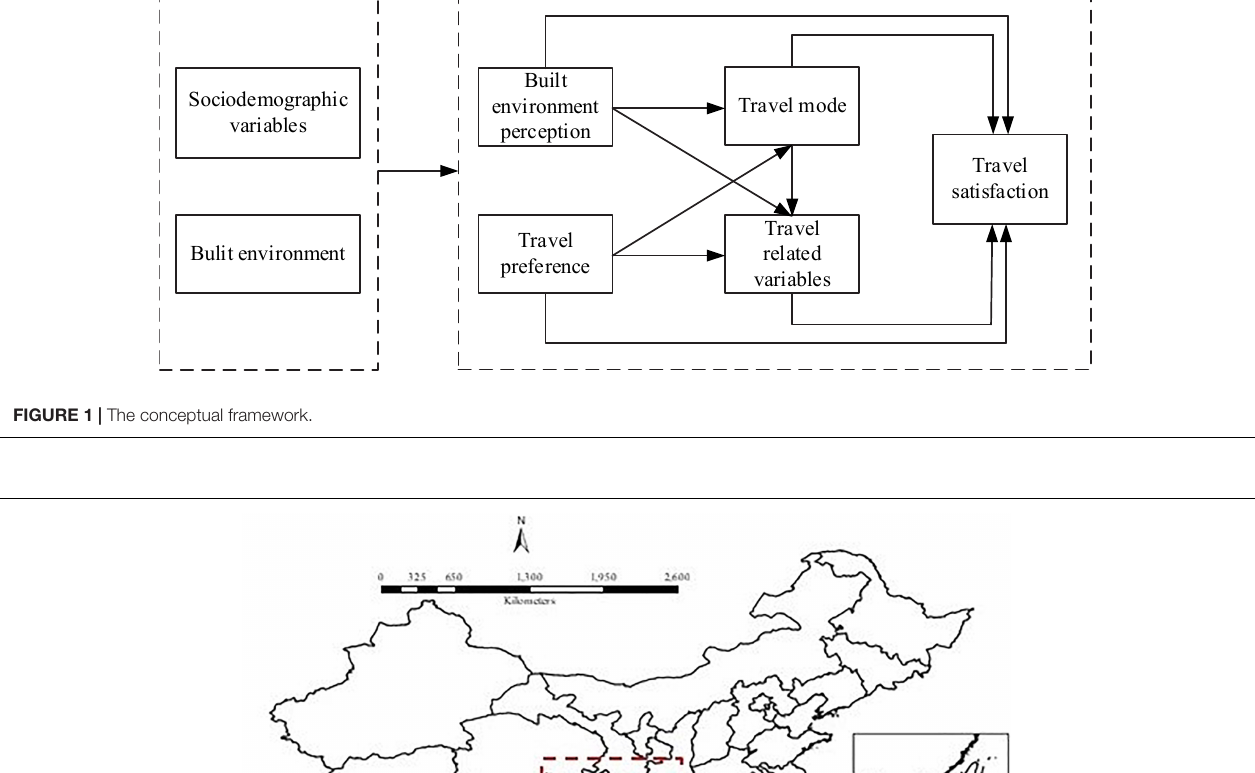
Frontiers in Ecology and Evolution |